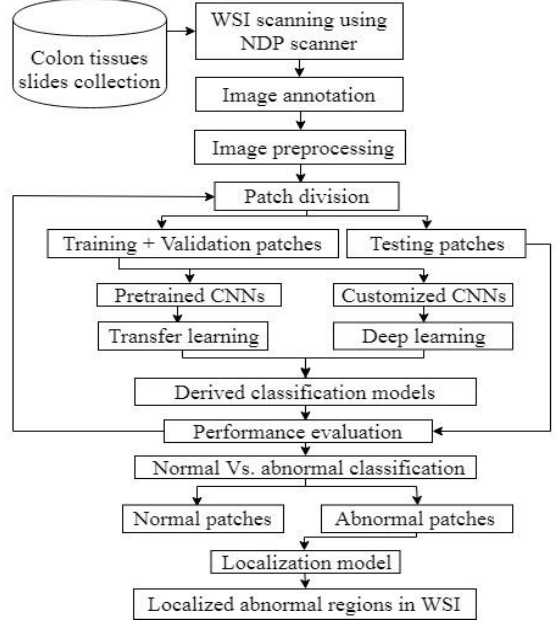
Figure 1. The overall outline of the study.